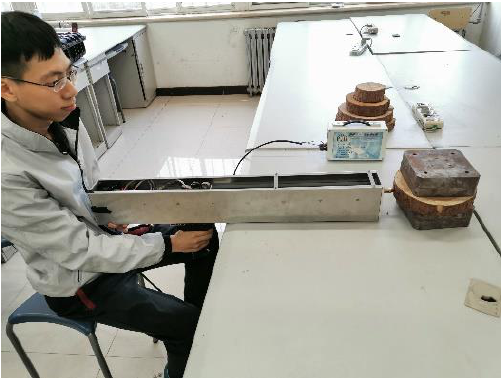
Figure 11. The operation of the microdestructive tree-ring measurement